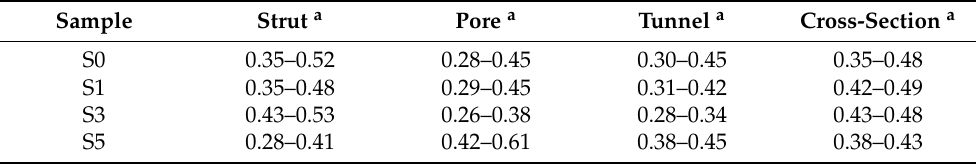
a Measurement results of Figure 4,